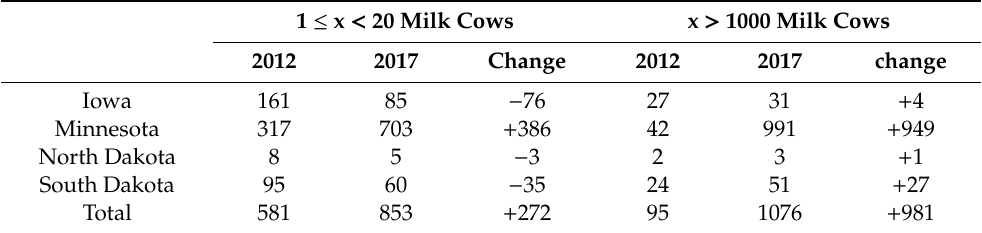
Table 2. Changes in inventories of milk cows at operations with sales of milk in 2012 and 2017. Source: https: //